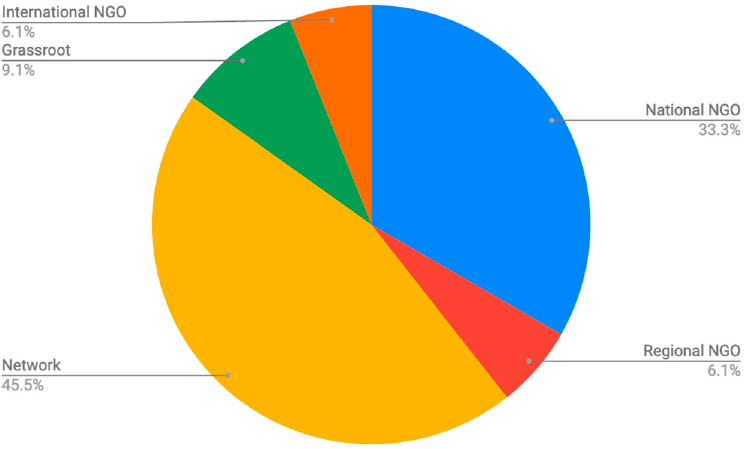
Figure 3. The composition of WGC (based on https://womengenderclimate.org/member/, accessed on 30 March 2021).